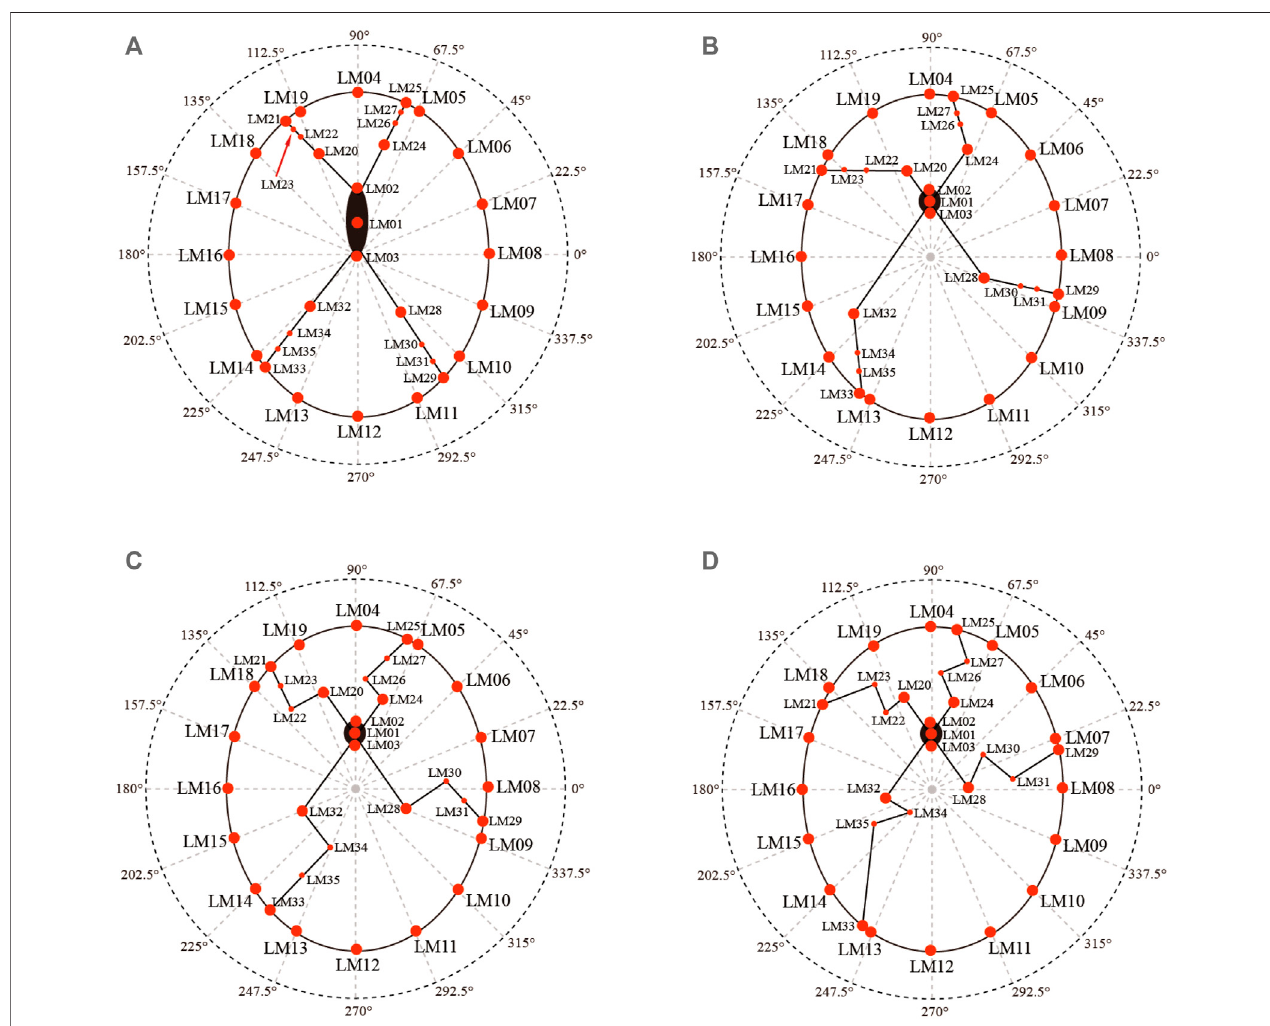
FIGURE2| De fi nitionofthe35landmarksonstarchgranule. (A) Extinctioncrosswithnobend; (B) eacharmwithonebend; (C) eacharmwithtwobends;and (D) , each arm with three bends (based on Zhang et al., 2021).